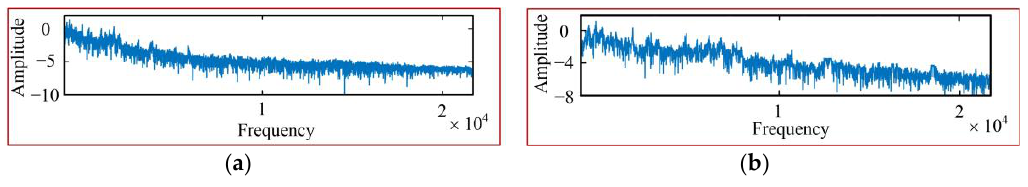
Figure 9. ( a ) Raw sound signals collected on-site; ( b ) Improved CEEMDAN denoised output signal.